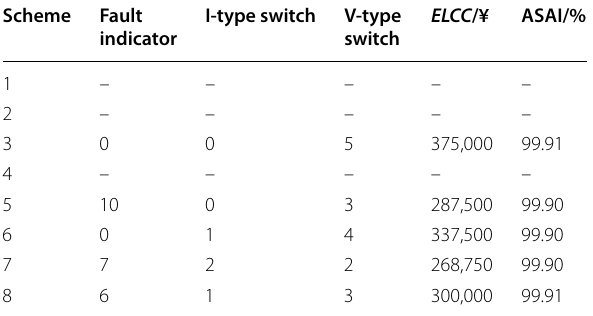
Table 7 Solution results when ASAI lim is 99.9% Scheme